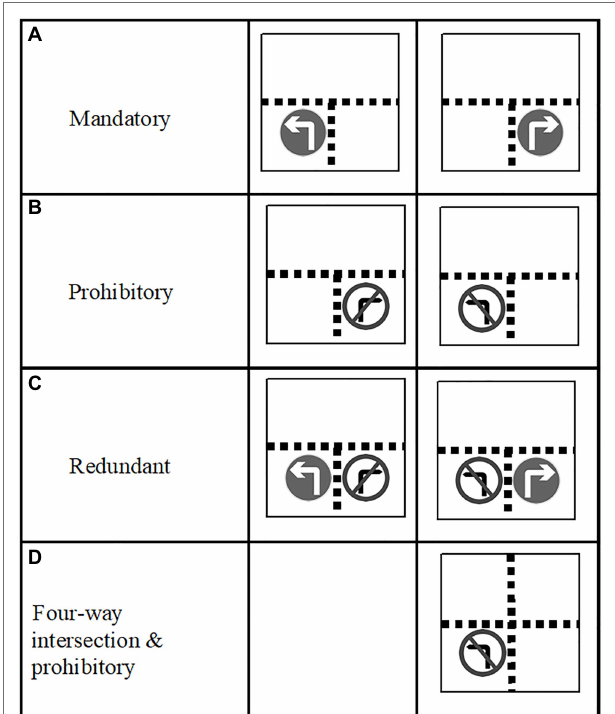
FIGURE 1 | This graph displays types of sign and intersection. (A) Two examples of mandatory signs at a T-junction. (B) Two examples of prohibitory signs at a T-junction. (C) Two examples of redundant information (mandatory sign and prohibitory signs) at a T-junction. (D) One example of prohibitory sign at a four-way